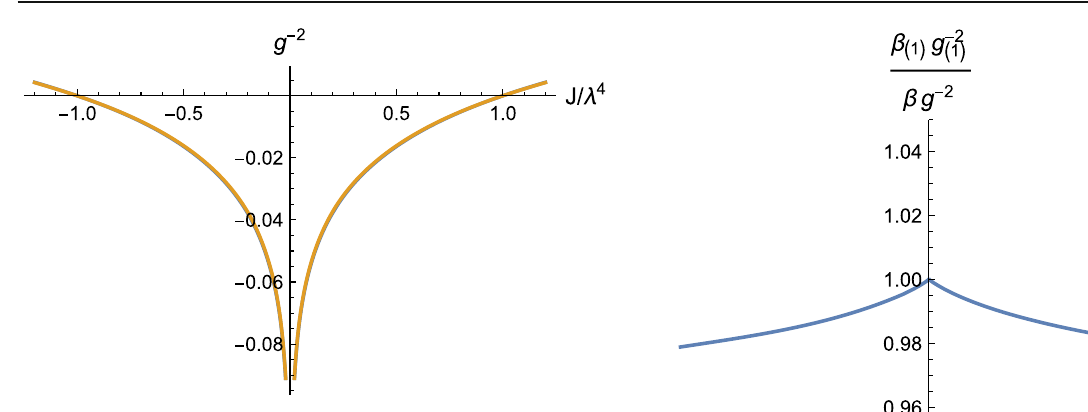
Fig. 4 The running coupling ¯ g − 2 ( J ) for the one-loop and all-loops cases in the effective SU ( 2 ) theory ( ε = 0 . 01)